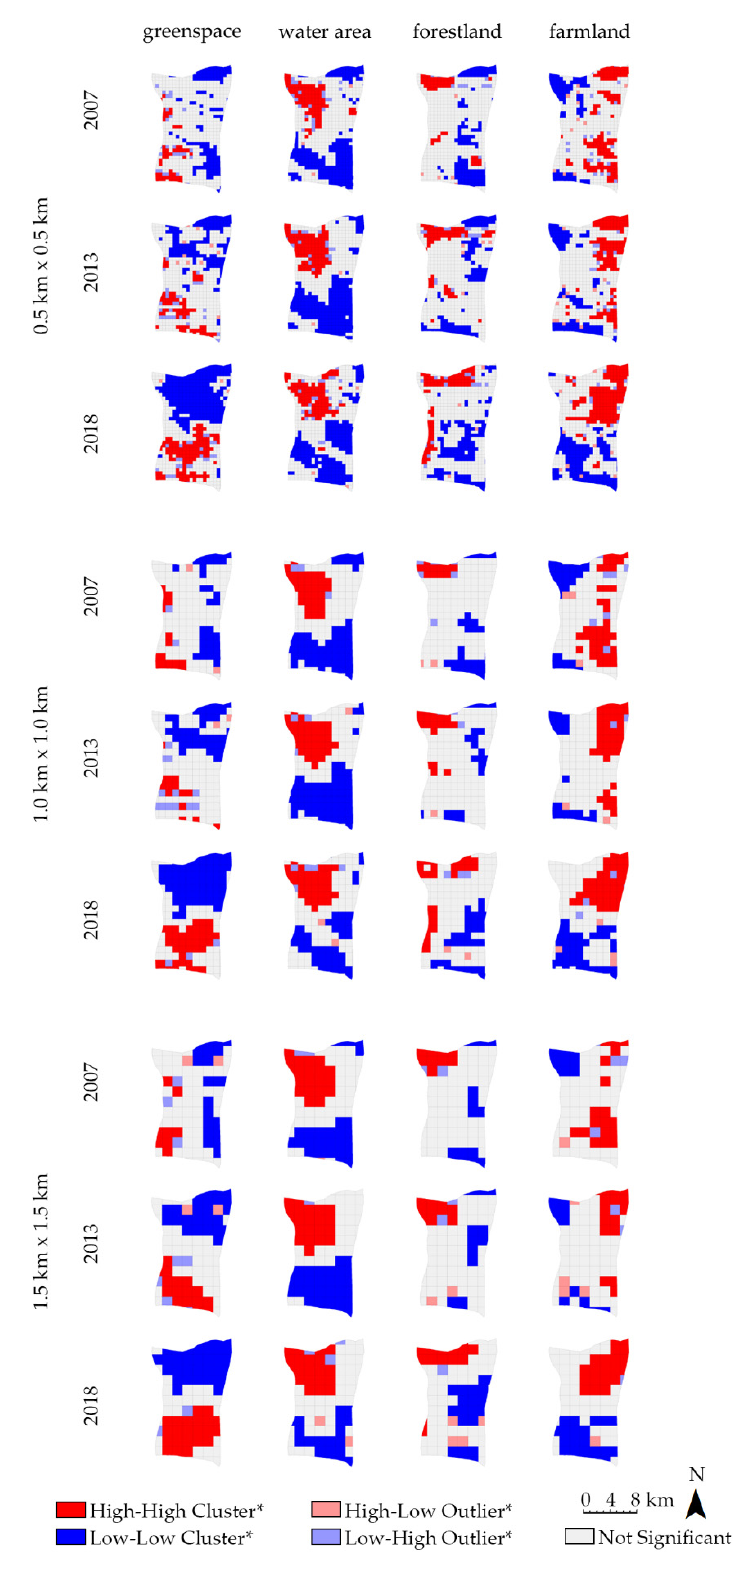
Figure 5. The LISA clustering map of PLAND for different GI. Note: * indicates 95% confidence interval ( p < 0.05).